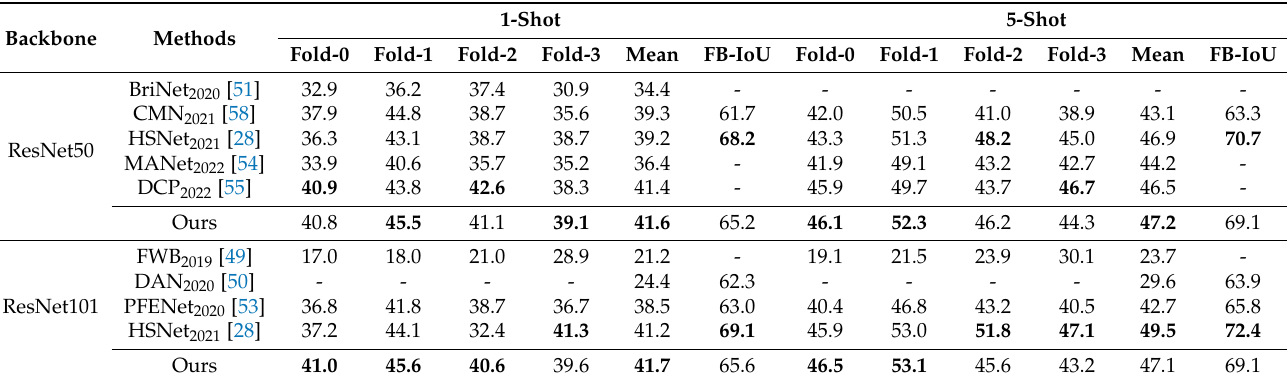
Table 2. Results and comparison of mIoU and FB-IoU on the four folds of COCO-20 i . Bold numbers represent the best performance.